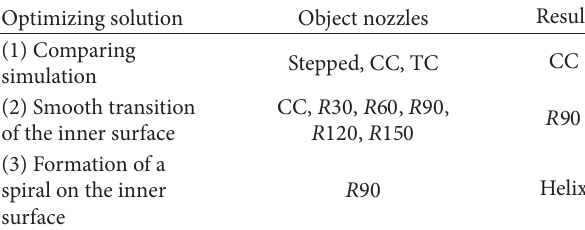
Table 2: Optimization procedures of nozzle structure design mod- els.